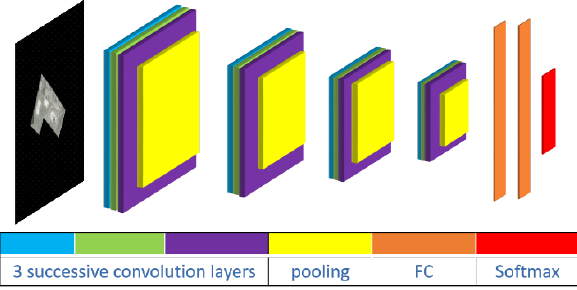
Figure 2: Architecture of